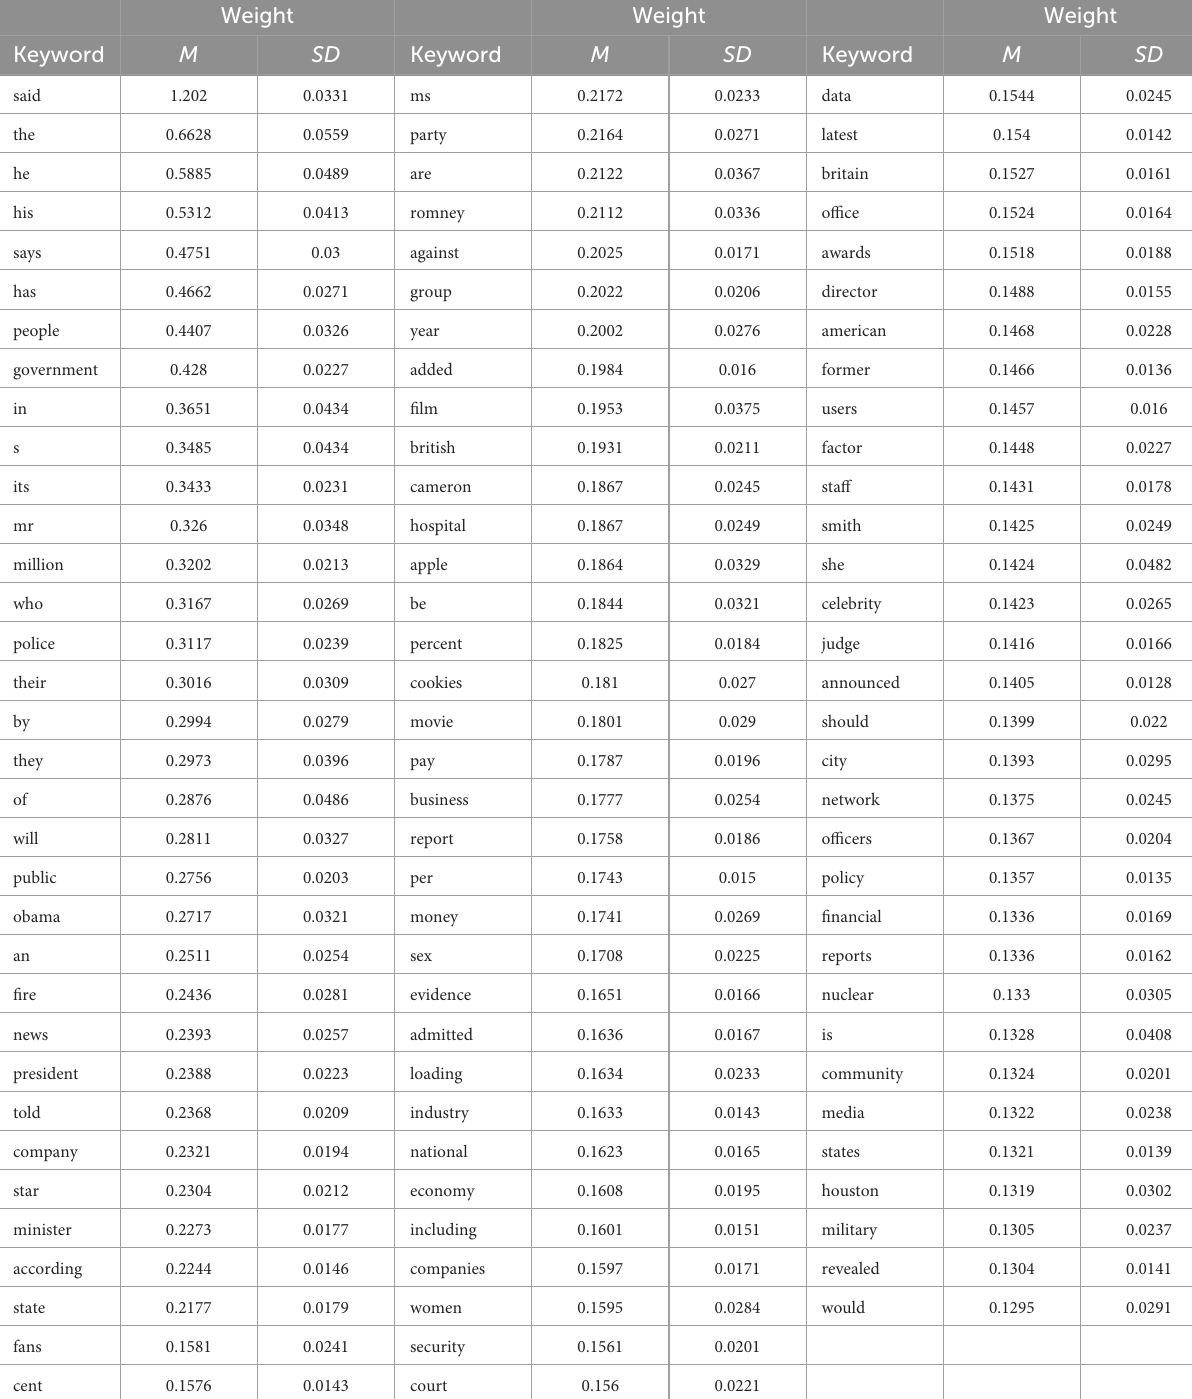
TABLE 2 Top 100 keywords extracted with SVMs for news in descending order based on the estimated weights averaged across the 1,000 resamplings. Weight Weight